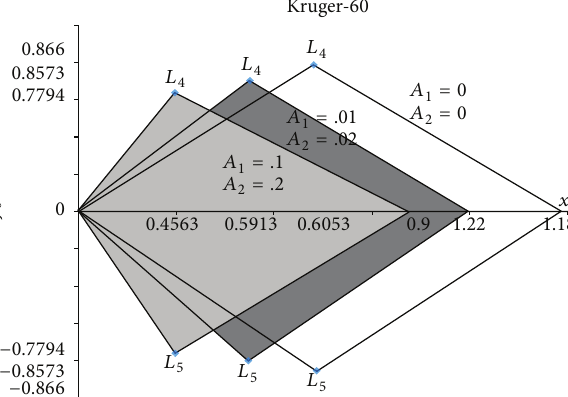
Figure 4: Location of triangular points for